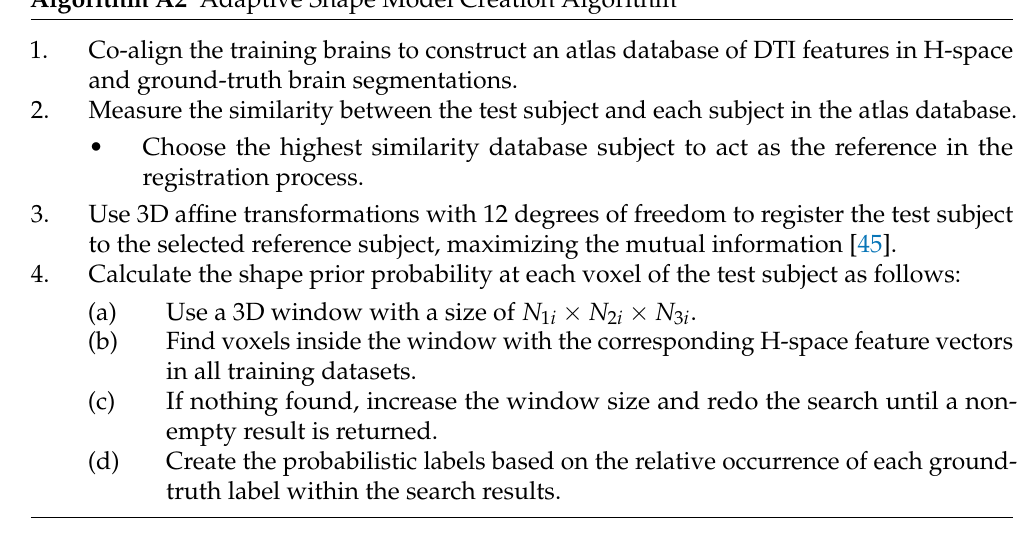
Algorithm A2 Adaptive Shape Model Creation Algorithm